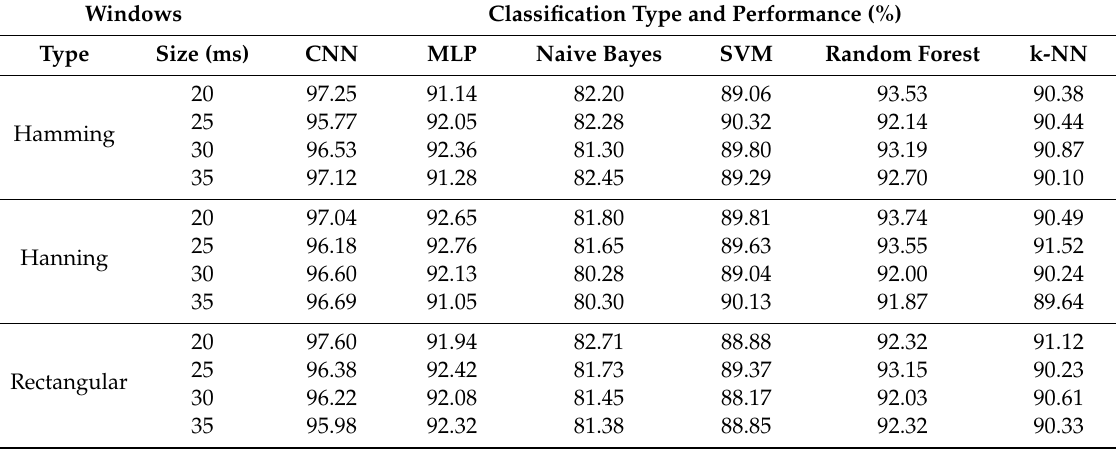
Table 6. Performance accuracy for male speakers based on GRU + EZDDMFCC.